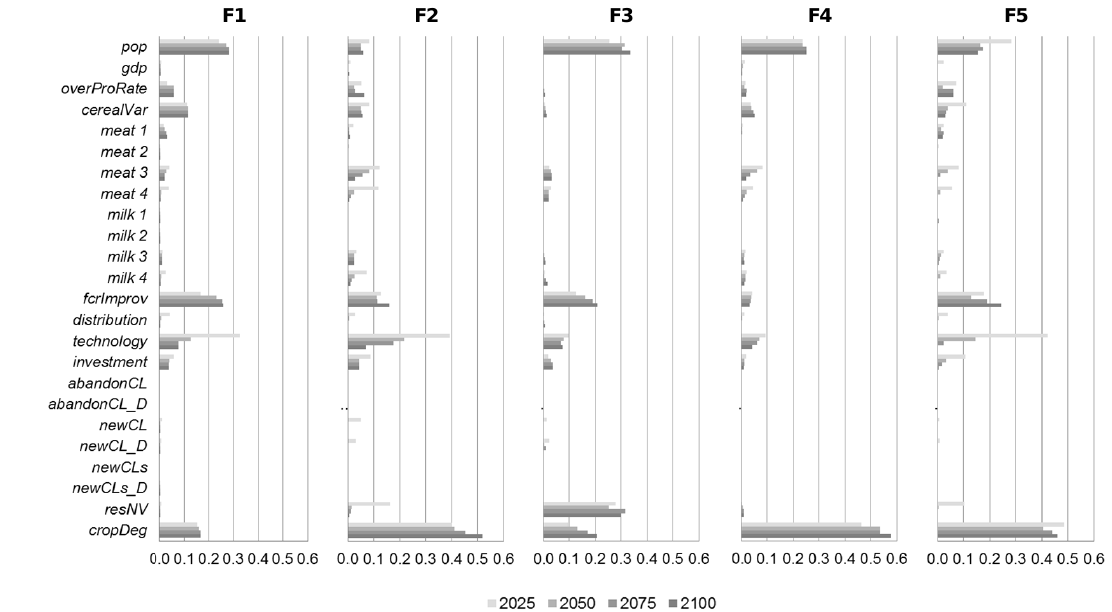
Figure C1. Total importance of cropland to uncertainty of input parameters conditional on